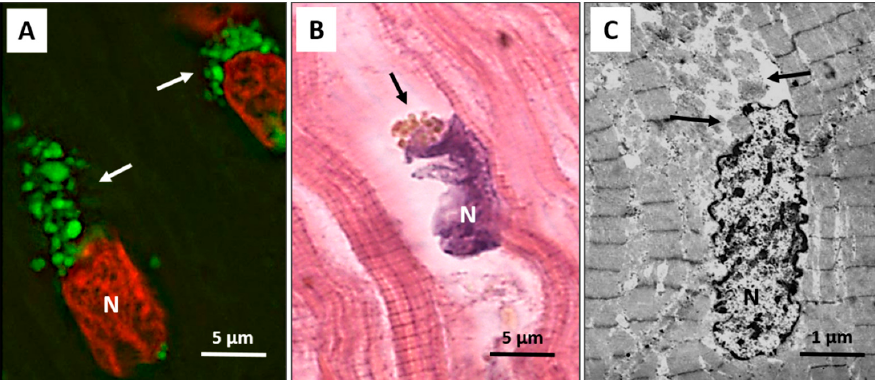
Figure 1. Failing heart. ( A ) Typical anti-LC3 immunofluorescence (green) of cardiomyocytes in an advanced stage of autophagic damage. Green bodies (arrows) are present around and much more at the pole of nuclei. Cardiomyocytes with massive green staining, in combination with the red staining of the nucleus, assume a “strawberry-like” appearance. N = nucleus in red; ( B ) Damaged cardiomyocytes show nuclei (N) very irregular in shape as if he had been bitten. Around these nuclei, the cytoplasm is devoid of organelles, and there are always clumps of brown debris bodies (arrow) (eosin and hematoxylin staining); ( C ) Representative transmission electron microscopy pictures show a damaged cardiomyocyte, with chromatin condensation in the nucleus (N) and deep invaginations of the nuclear envelope. Cytoplasmic granular material without organelles is present around the nucleus and near the nuclear pole (arrows).